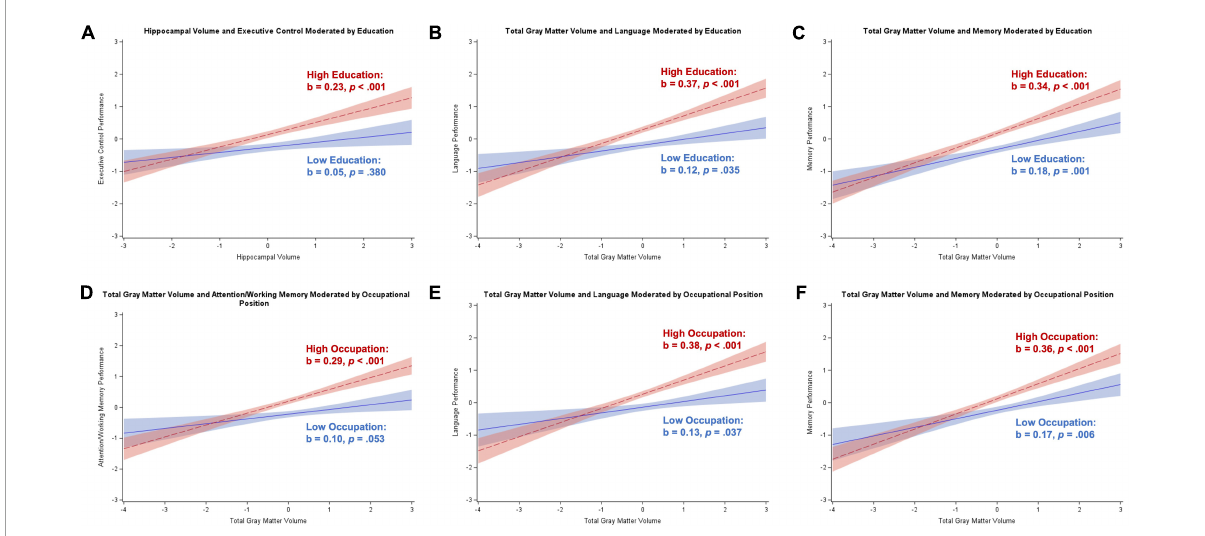
FIGURE1 Plots of significant moderations by education and occupational position of the associations between cognition and brain volume in participants without dementia. High education or occupational position corresponds to 1 SD above the mean and low education or occupational position corresponds to 1 SD below the mean. The red dotted line represents high cognitive reserve, and the blue solid line represents low cognitive reserve. Shaded areas represent 95% confidence intervals. Cognition and brain volume were standardized. (A) Significant positive association between hippocampal volume and executive control for individuals with high education; non-significant for low education. (B) Significant positive association between total gray matter volume and language for individuals with low and high education; stronger relationship for high education. (C) Significant positive association between total gray matter volume and memory for individuals with low and high education; stronger relationship for high education. (D) Significant positive association between total gray matter volume and attention/working memory for individuals with high occupational position; non-significant for low occupational position. (E) Significant positive association between total gray matter volume and language for individuals with low and high occupational position; stronger relationship for high occupational position. (F) Significant positive association between total gray matter volume and memory for individuals with low and high occupational position; stronger relationship for high occupational